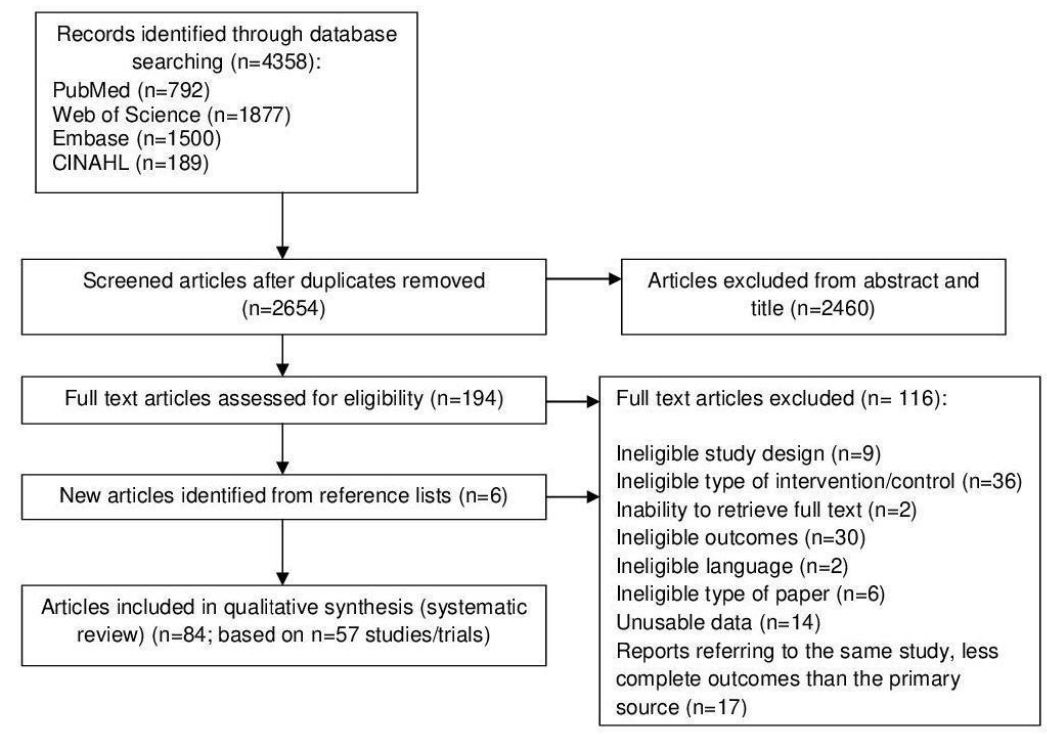
Figure 1. Flow diagram of literature search and study selection.